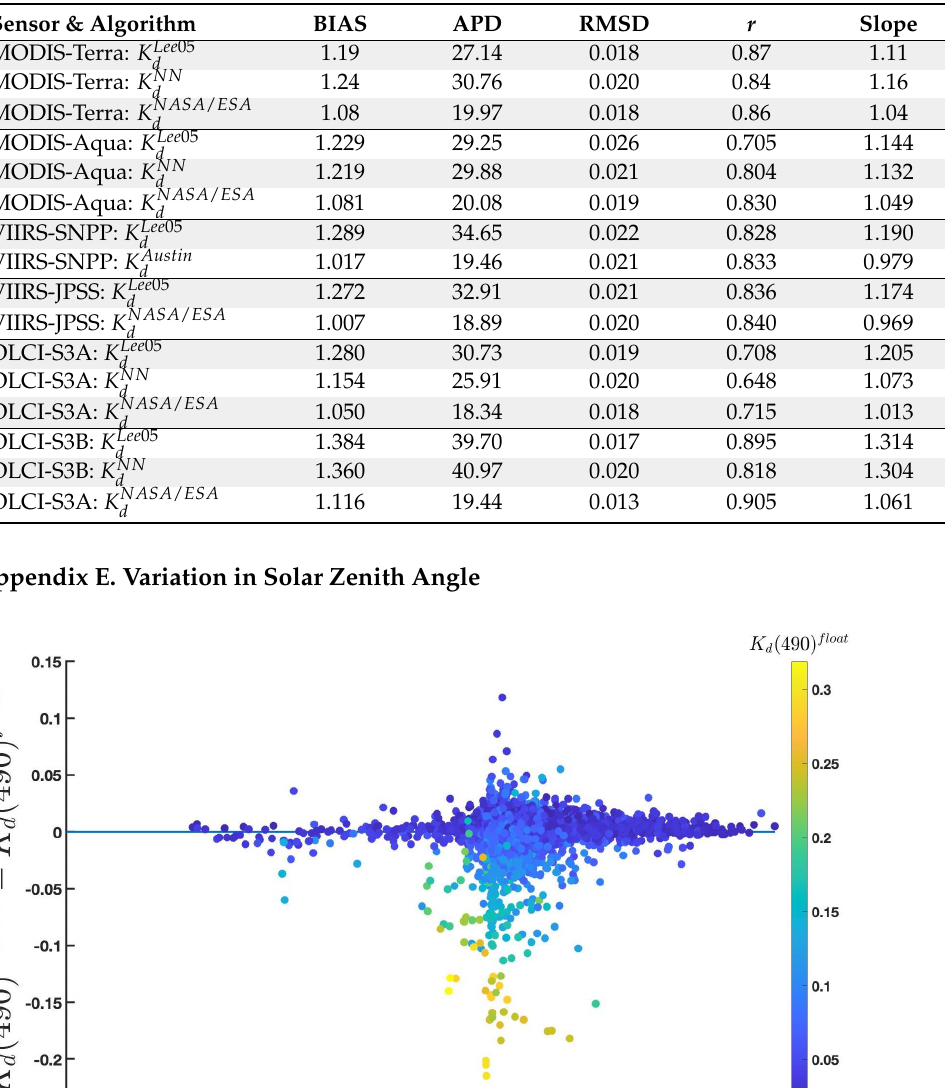
Table A4. Results at 490 nm when the intercept is forced to 0. See Methods section for definitions of statistical performance metrics.